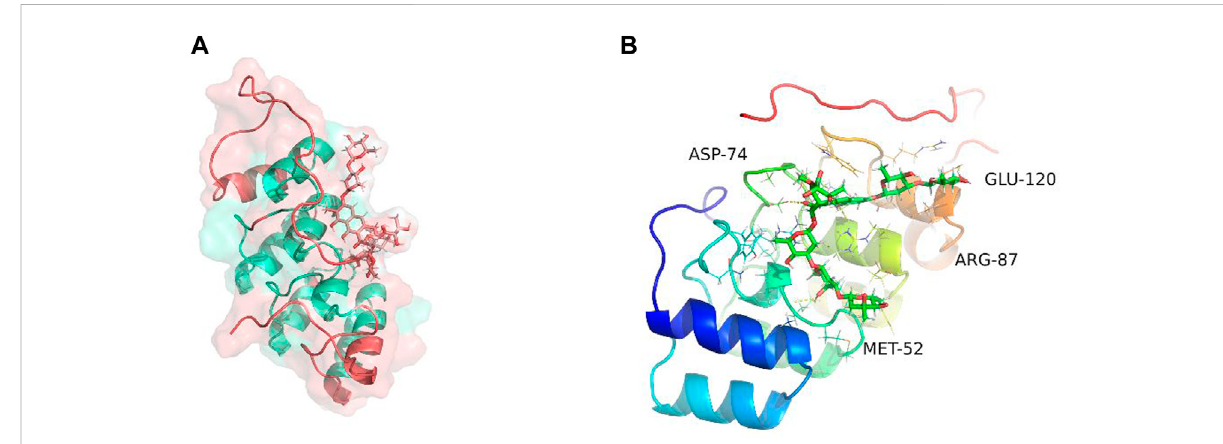
FIGURE 8 Binding site of plicamycin on the CDKN2A protein. (A) Docking pose; (B) Amino acids and docking sites.